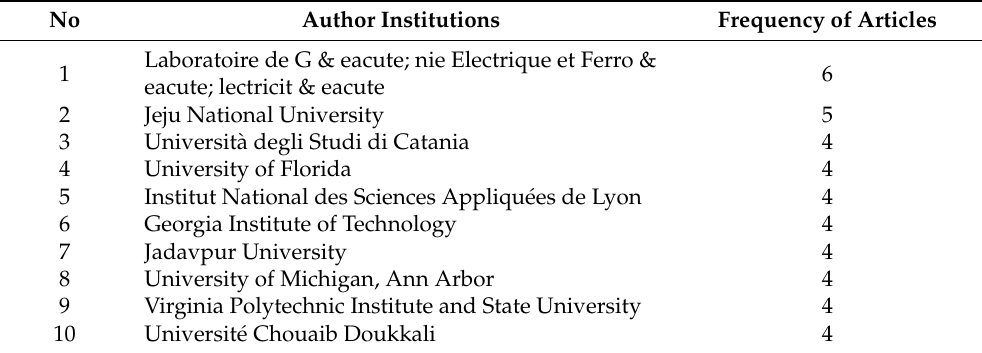
Table 5. Top 10 affiliations in PMEH for low-power applications research